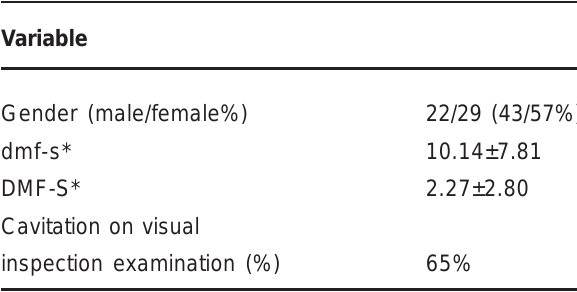
TABLE 1- Gender, age, dmf-s, DMF-S and percentage of